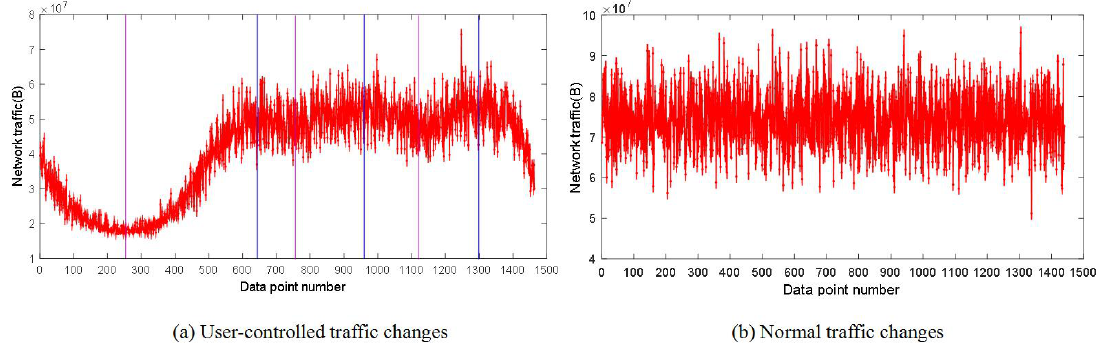
Figure 13. The large-scale of flow simulation.